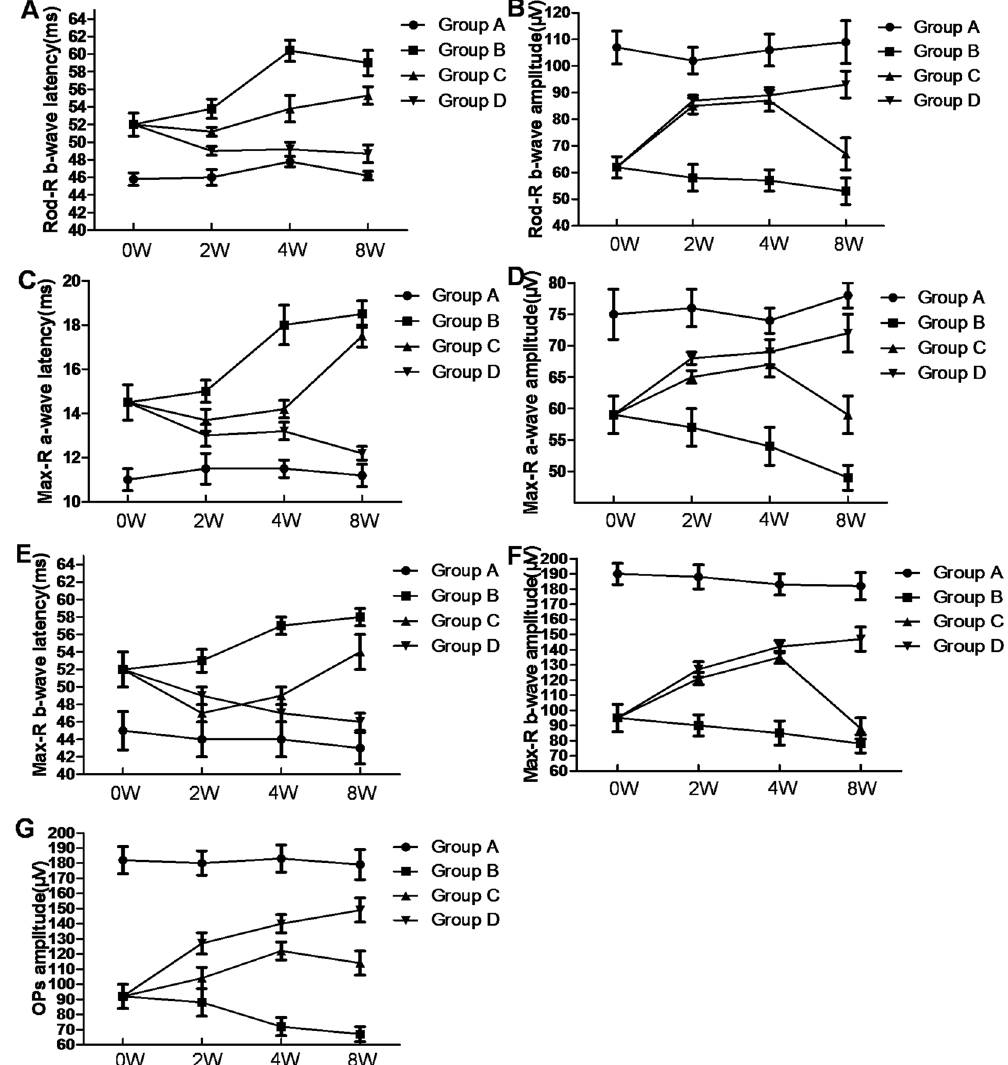
Figure 6. NSC transplantation enhanced b-wave amplitude and reduced the latency of ERG responses. ( A , B ) ERG responses (b-wave and a-wave) were significantly lower in Group B than in Group A. The mean maximal a-wave amplitudes were significantly higher in Groups C and D than in Group B at all time points between 2 and 8 weeks following cell transplantation. ( C – F ) Both Rod-R and Max-R b-wave recordings were significantly higher across light amplitudes in Groups C and D than in Group B at subsequent time points (2 to 8 weeks following transplantation). ( G ) The OP amplitudes were significantly higher in Groups C and D than in Group B at all time points between 2 and 8 weeks following cell transplantation. Data are presented as the mean ±